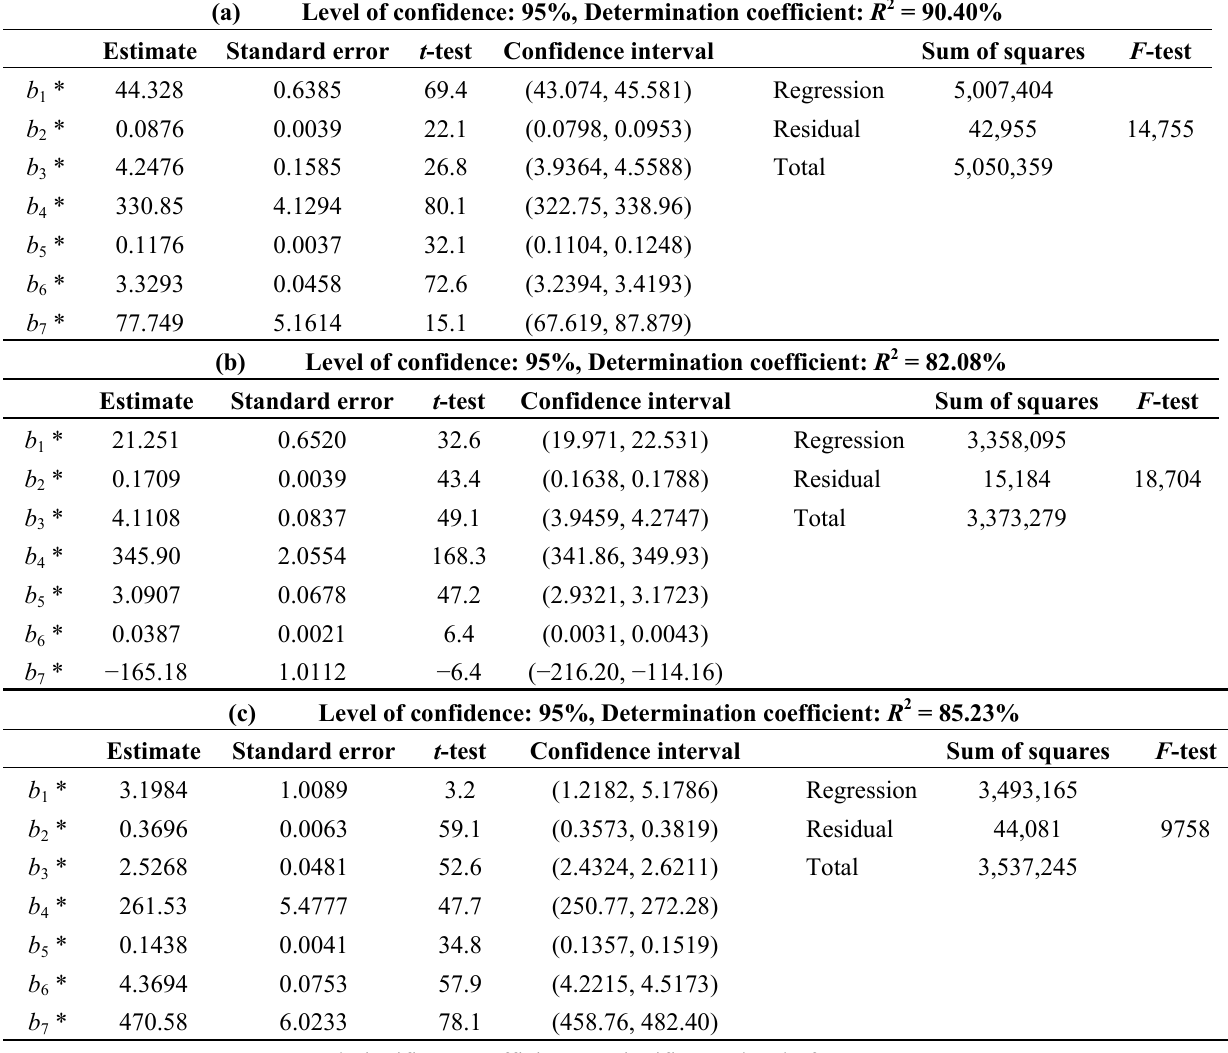
Table 4. Estimation of empirical regression coefficients and analysis of variance of Level of confidence: 95%, Determination coefficient: R 2 =